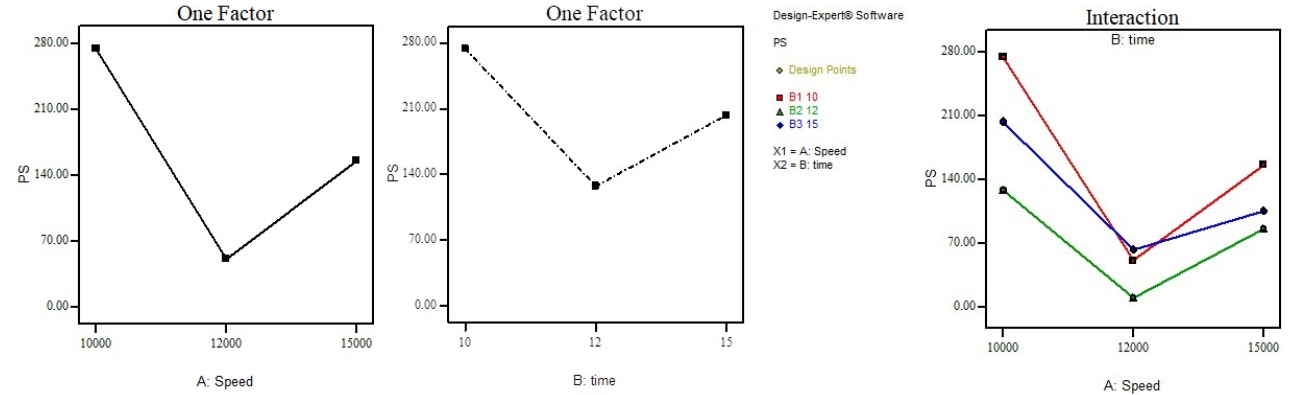
Figure 2. Effect of homogenization speed and time on the particle size (PS).